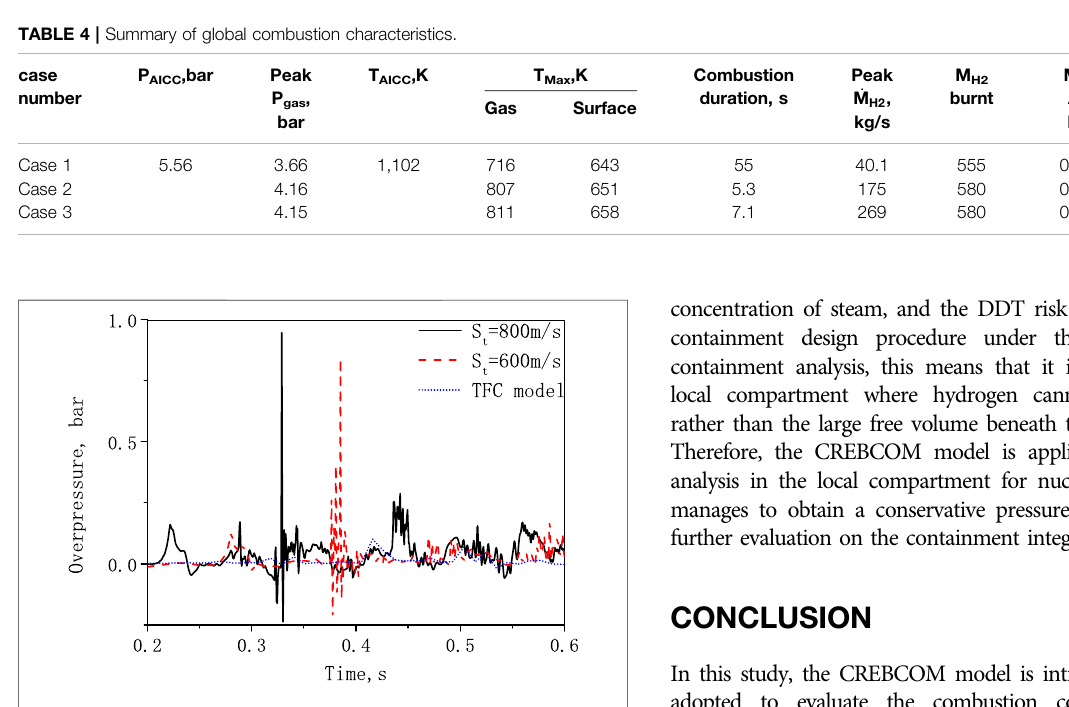
FIGURE 12 | Pressure difference between the two sides of the PZR compt. ceiling.